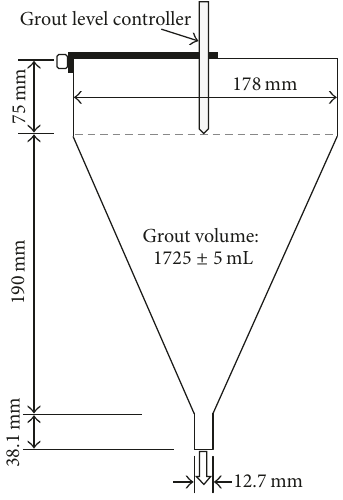
Figure 2: Flow cone geometry for hydraulic cement grout flow